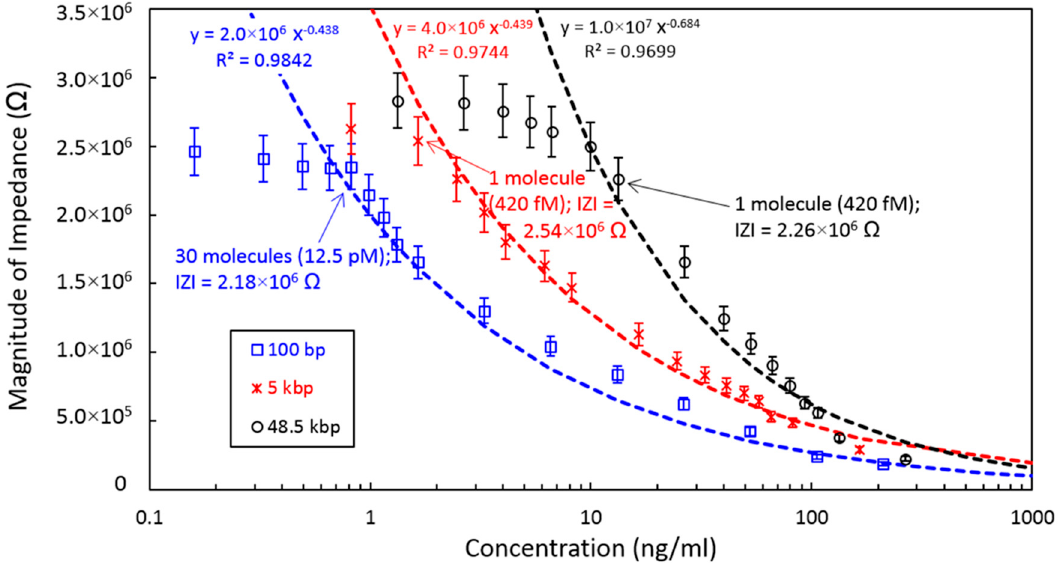
Figure 5. Electrical impedance values as functions of DNA concentration, based on measurements of 100 bp, 5 kbp, and 48.5 kbp DNA in a 800 nm electrode gap with an applied electric field strength of 0.5 MV/m.